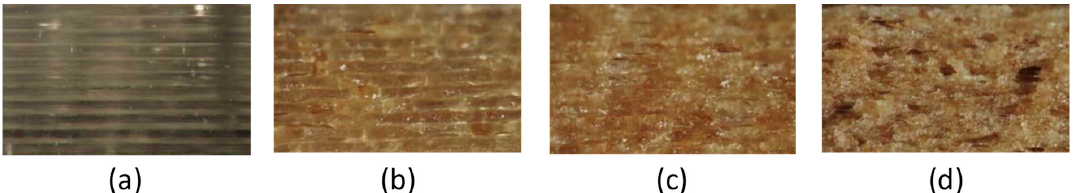
Figure 11. Appearance of the 3D printed part at 40x magnification and with wood content: ( a ) 0%, ( b ) 10%, ( c ) 20%, and ( d ) 30% [14].